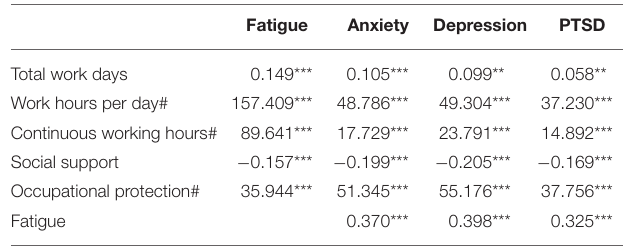
TABLE 1 | Descriptive statistics of survey data. TABLE 2 | Correlation analysis results indicating correlations among explanatory variables, mediation variable and response